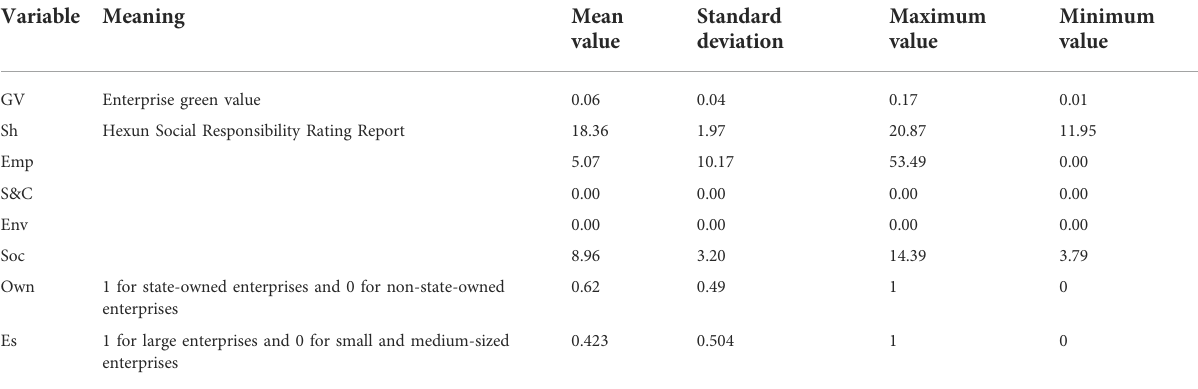
TABLE 1 Variable de fi nitions and descriptive statistics (N =